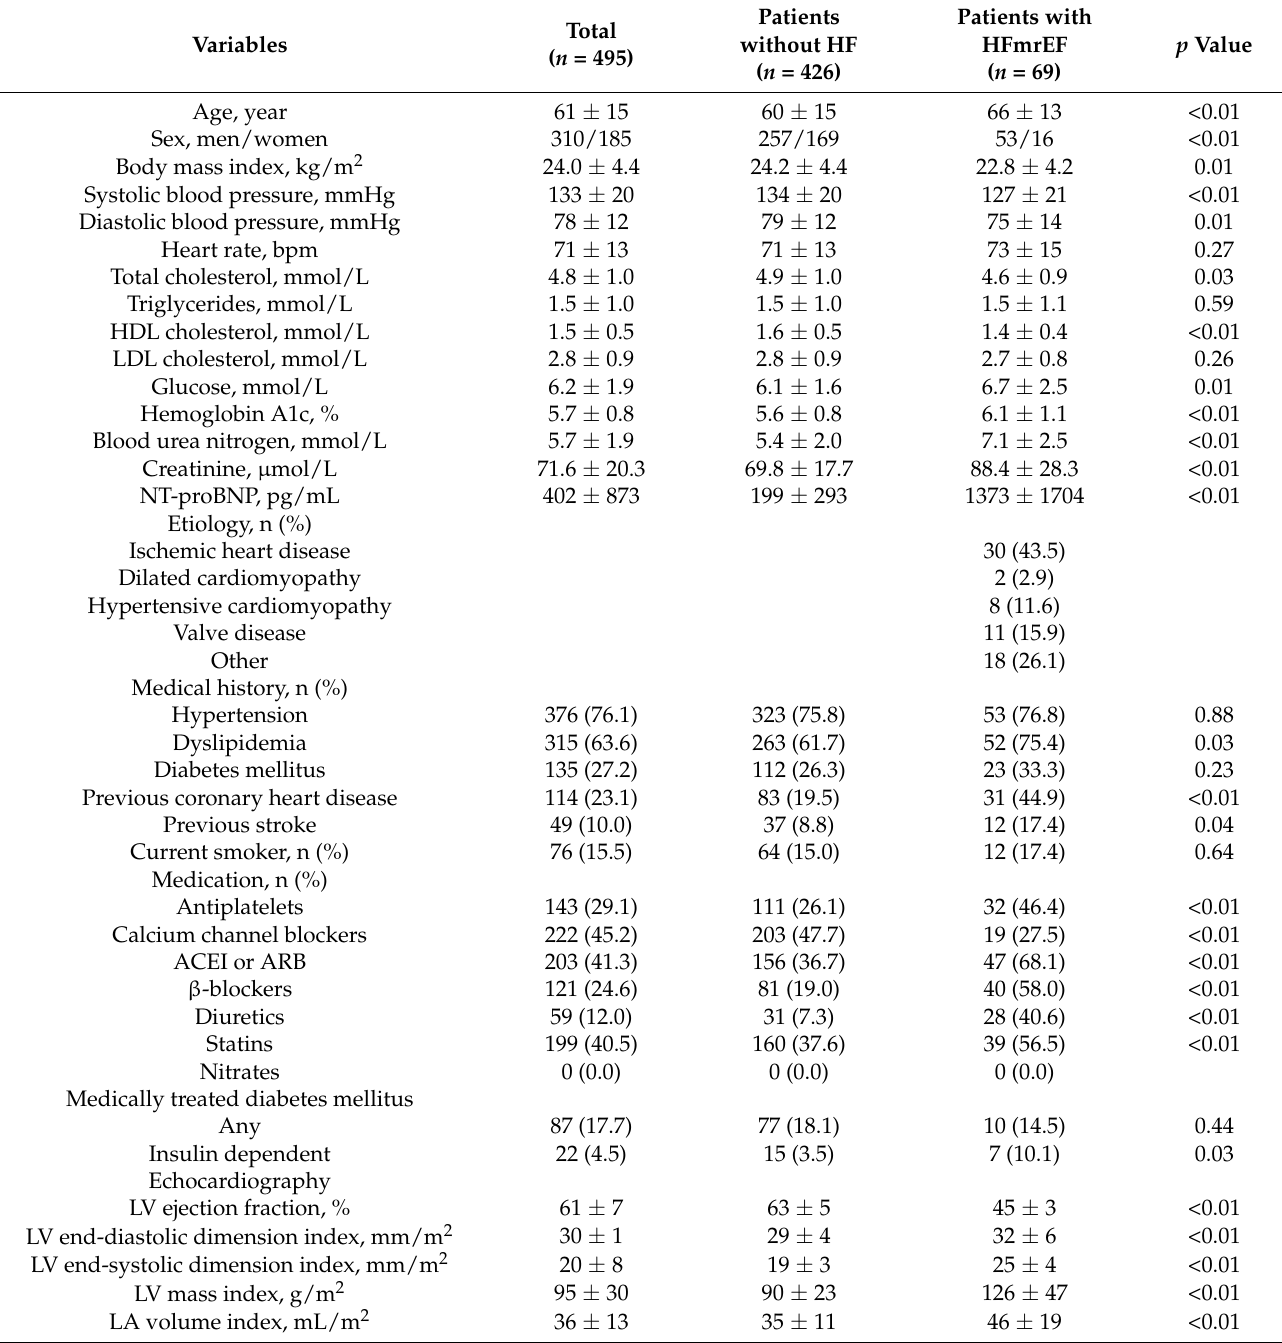
Table 1. Clinical characteristics of the subjects correspond to Study Protocol